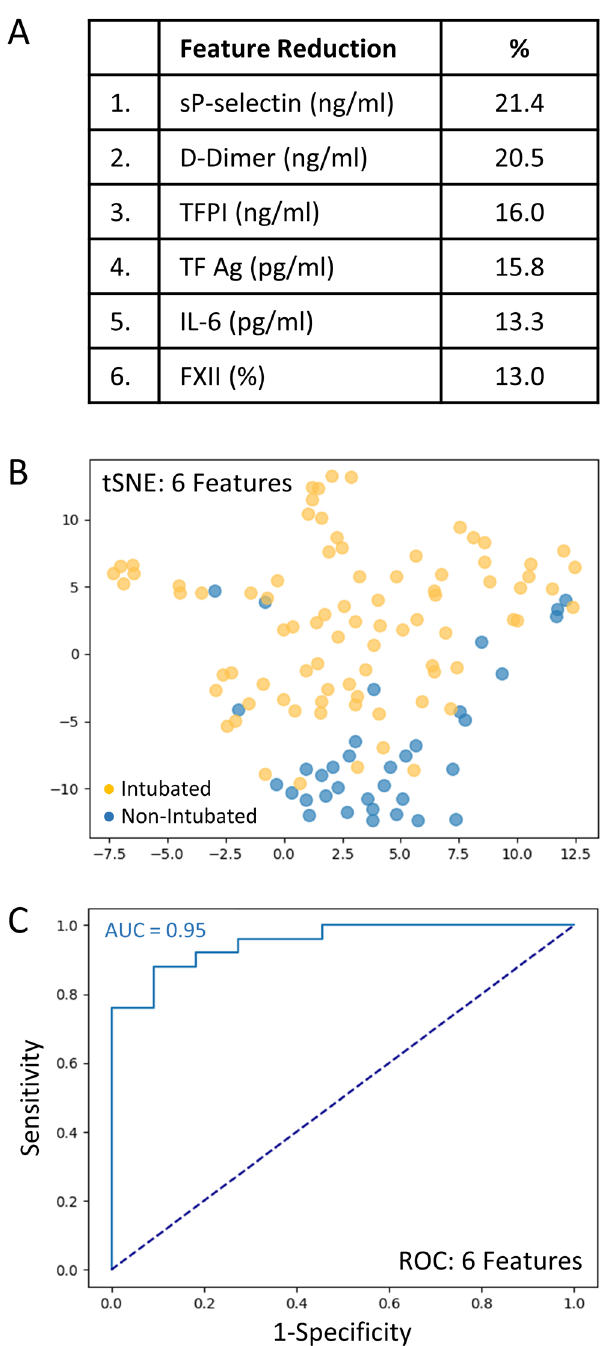
Figure 2. The top six variables associated with intubation risk of critically ill patients with COVID-19. ( A ): Feature reduction demonstrating the top six patient variables that classify COVID-19 intubation status, with their % association. ( B ): COVID-19 patients plotted in two dimensions following dimensionality reduction in their top six patient variables by stochastic neighbor embedding (tSNE). Orange dots represent intubated COVID-19 patients, whereas blue dots represent non-intubated COVID-19 patients. The dimensionality reduction shows that based on the top six patient variables, the two cohorts are distinct and easily separable. The axes are dimensionless. ( C ): Receiver operating characteristic (ROC) curve analysis of COVID-19 patients, intubated or non-intubated, using the top six patient variables, demonstrates an area-under-the-curve (AUC) of 0.95. The diagonal broken dark blue line represents chance (AUC 0.50). The cut-off values were: sP-Selectin > 21.5 ng/mL; D-Dimer > 1.47 ng/mL; TFPI > 21.3 ng/mL; TF activity > 72.8 pg/mL; IL-6 > 14.0 pg/mL; and FXII < 71.5%.